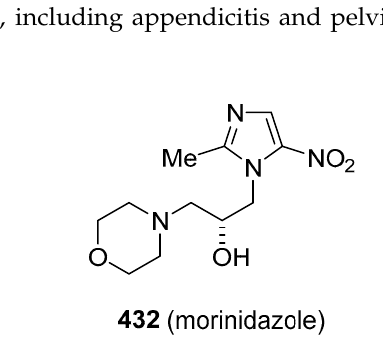
Figure 14. Structure of morinidazole ( 432 ).